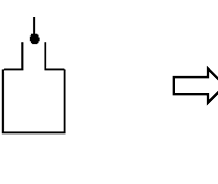
Figure 7. Equivalent circuit of cavity. Figure 6. Equivalent circuit of cavity.